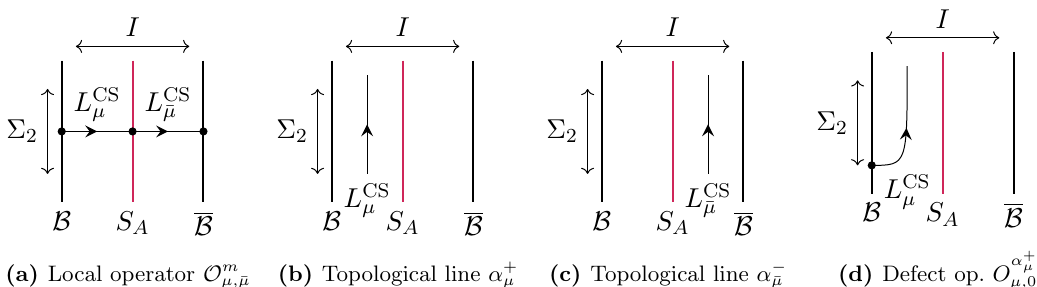
Figure 4. The RCFT T A can be obtained by considering the 2+1-d CS theory on I (cid:2) (cid:6) 2 as in (cid:12)gure 3 with the surface operator S A inserted in the middle of the interval I . (a): a local operator O m in the Verma module V (cid:22) (cid:10) V (cid:22) (cid:22) can be realized as the Wilson lines L CS (cid:22); (cid:22) (cid:22) at S A . The number of possible ways of such connections determines the multiplicity of the Verma module in the total Hilbert space of T A . (b): The bulk Wilson line L CS and to the left of S A de(cid:12)nes a 2d topological line (cid:11) + ( L (cid:22) ) in T A . (c): The bulk Wilson line L CS along the 2d spacetime (cid:6) 2 and to the right of S A de(cid:12)nes another 2d topological line (cid:11) (cid:0) ( L (cid:22) (cid:22) ) in T A . (d): A defect operator at the edge of the line (cid:11) + L CS on the left boundary B . The resulting defect operator O (cid:11) (cid:22)